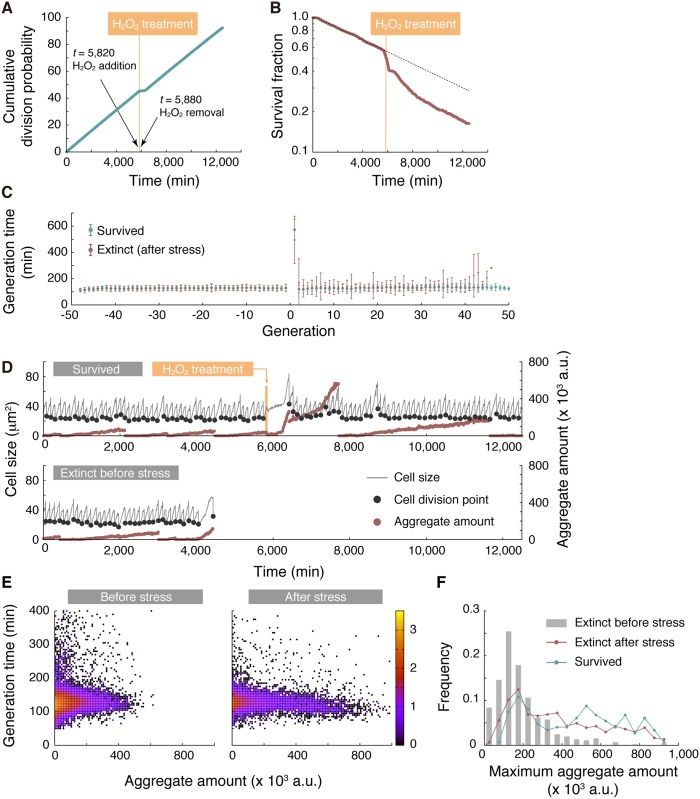
Oxidative stress does not induce replicative aging.(A) Cumulative division probability. Mean generation time, estimated as a reciprocal of the slope of the line, was 130 min before stress and 134 min after recovery. The orange thick line represents the period of H2O2 treatment (60 min). (B) Survival curve before and after stress treatment. The broken line represents a predicted survival curve without stress treatment. (C) Transitions of mean generation time before and after stress. Positive and negative generations indicate the generations after and before H2O2 treatment, respectively. Lineages that expired before stress treatment were excluded from the analysis. Error bars show standard deviations. (D) A representative example of a lineage that survived until the end of measurement (top) and a lineage that died before stress treatment (bottom). Stress treatment induces much higher levels of aggregation than in normal conditions. (E) Density maps for the relationship between generation time and aggregate amount. (Left) Before stress treatment. (Right) After stress treatment. Density of points is represented in color (log10[Counts]). (F) Distributions of maximum aggregate amount on a lineage. Gray color indicates the lineages that were extinct before stress; red is used for the lineages that were extinct after stress; and blue was used for the survived lineages. The numerical values for the plots are deposited in the Dryad repository: http://dx.doi.org/10.5061/dryad.s2t5t/15.